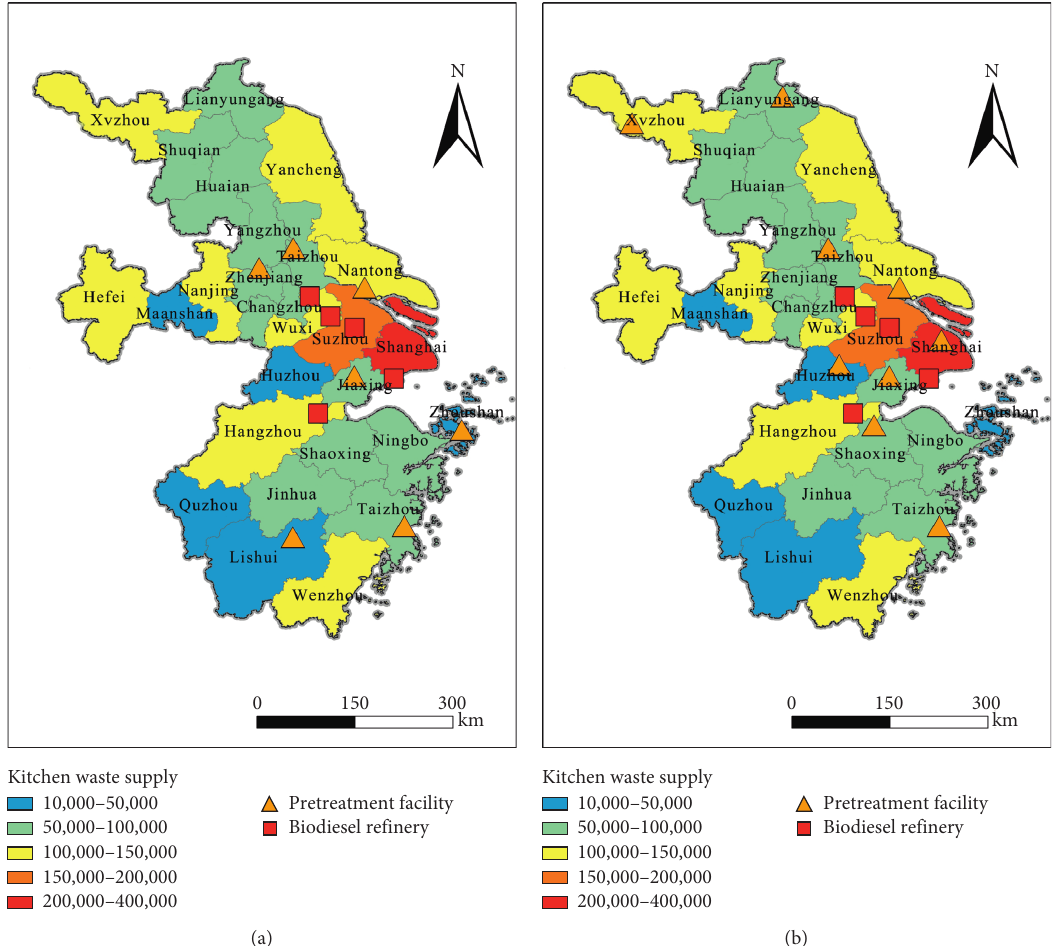
Figure 7: Network structure sensitivity analysis of transportation cost. (a) Transport cost of 0.14 Yuan/ton-km. (b) Transport cost of 0.26